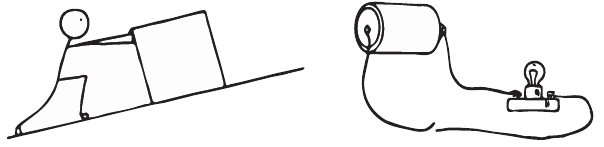
FIG. 1. Instances ‘‘Pushing a heavy box up a hill’’ and ‘‘A battery, bulb and switch’’